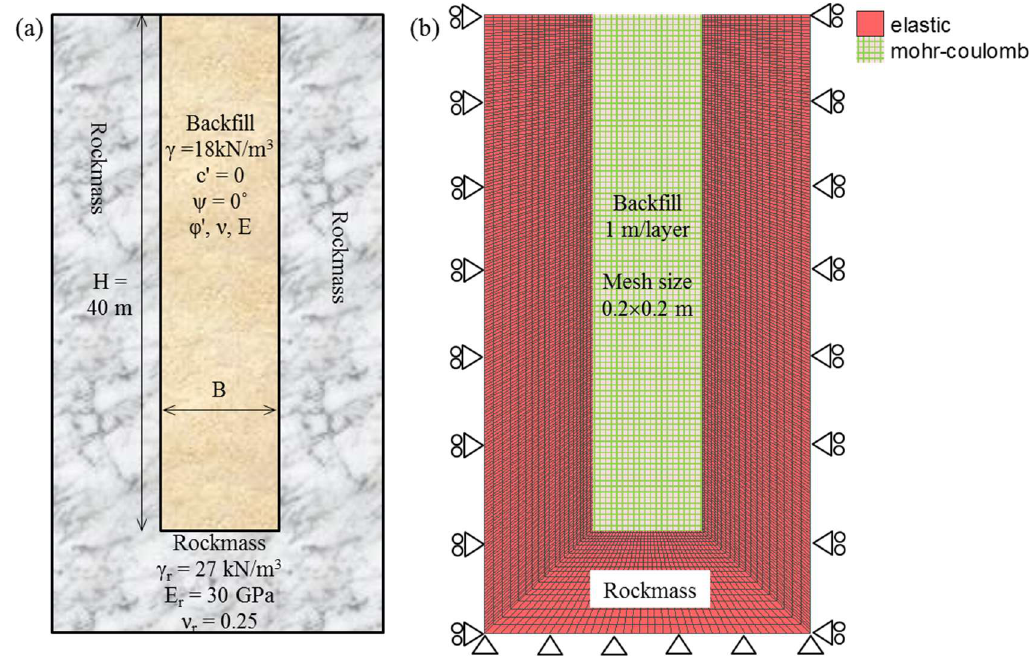
Figure 2. ( a ) A backfilled opening and ( b ) the corresponding numerical model.